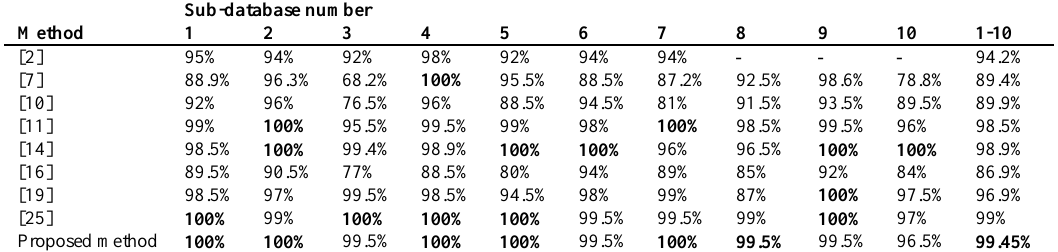
Table 8. Comparison between pedestrians’ detection rate (average of sensitivity and PPV) in proposed method and related works on database 1.